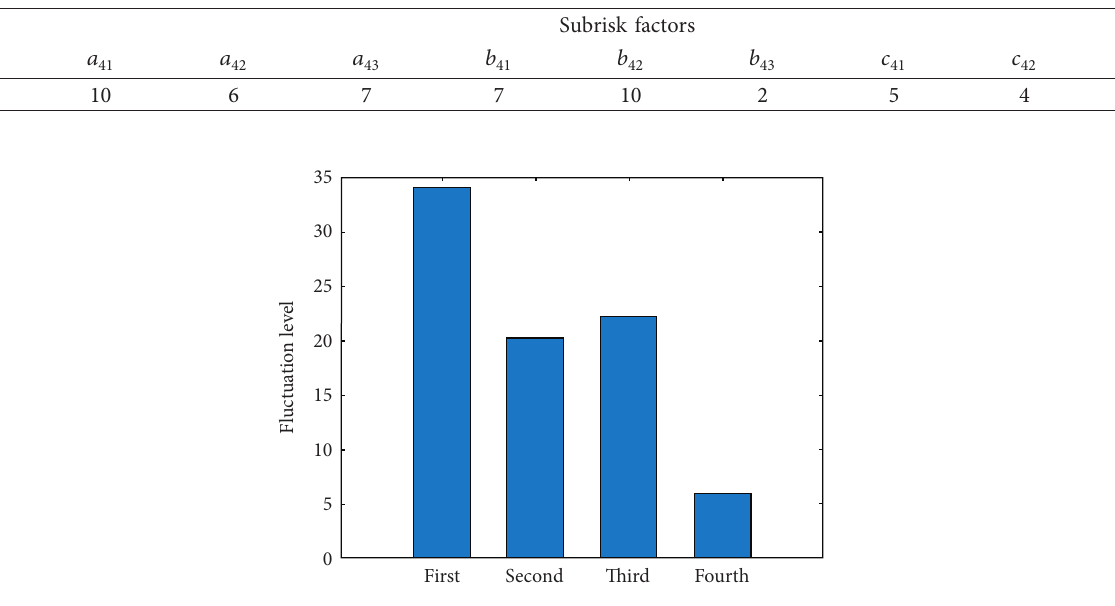
Table 10: Scoring results of subrisk factors of the fourth-level nodes.